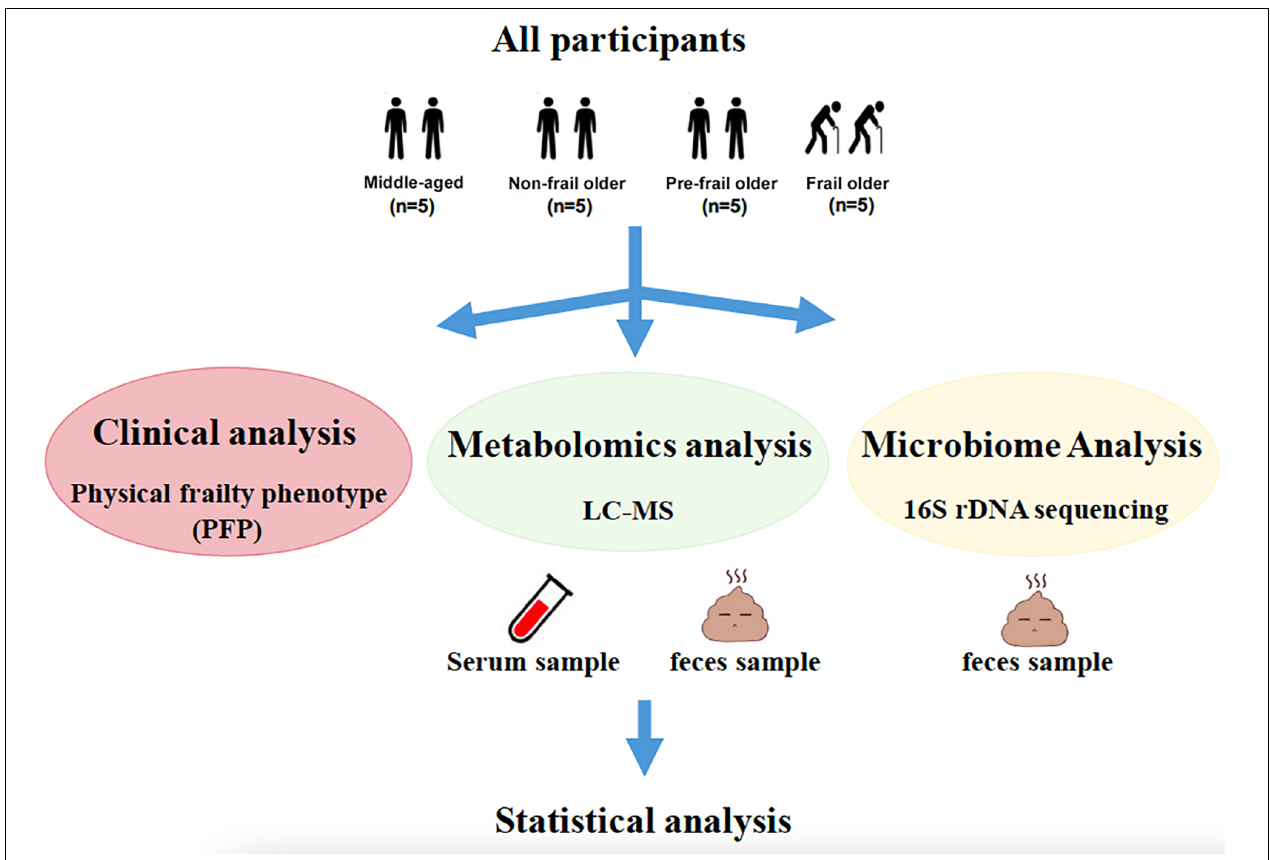
FIGURE 1 | Diagram of the study